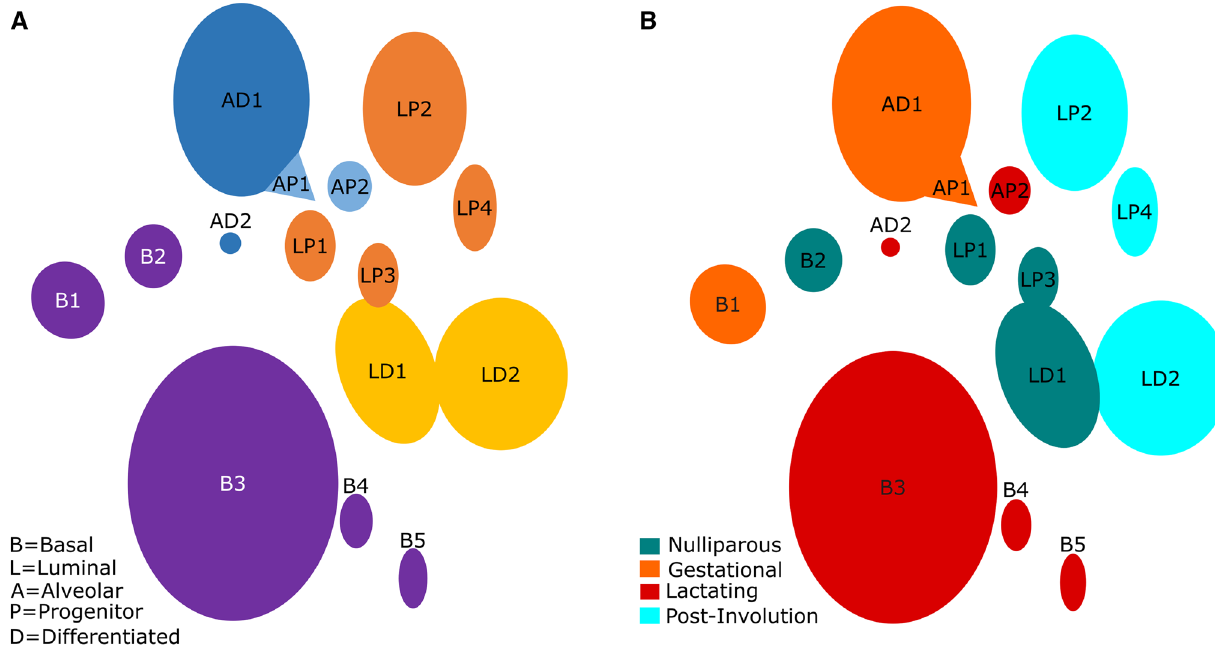
Fig. 3 Mammary cell populations in the adult mouse in nulliparous, gestational, lactating, and post-involution stages. A 15 cell popula- tions, basal (purple), differentiated alveolar (blue), alveolar progenitor (light blue), luminal progenitor (orange), and luminal differentiated (yellow) cell populations are shown. B 15 cell populations, nulliparous (teal), gestational (orange), lactating (red), and post- involution (tur- quoise) cell populations are shown. Based on the work of Bach et al.